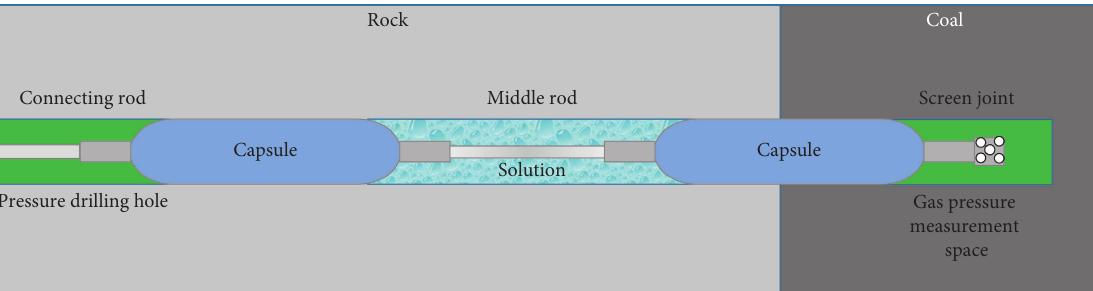
Figure 1: Capsule-mucus sealer schematic.